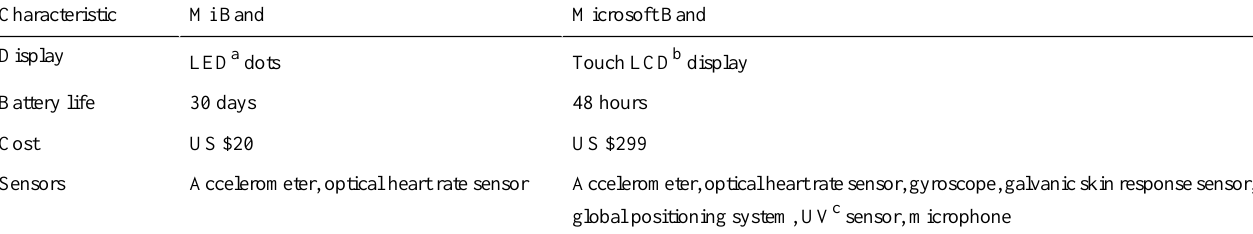
Microsoft BandMi